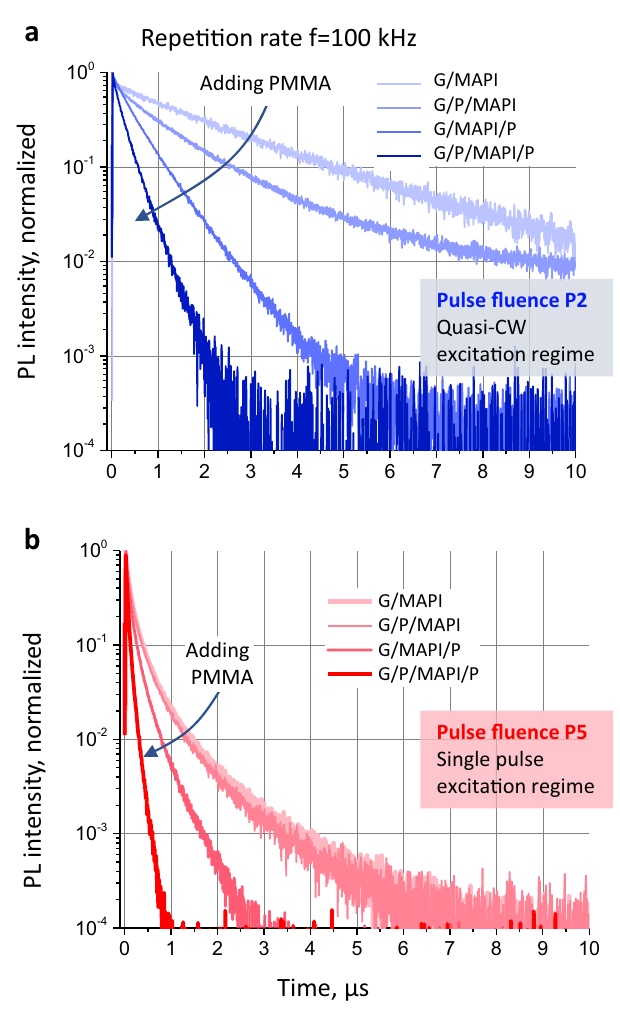
Fig. 3 PL decays of all samples at 100 kHz repetition rate (10 µ s distance between the laser pulses). a Low pulse fl uence (P2). b High pulse fl uence (P5). Note that all decays in a are in the quasi-CW excitation regime, while all decays in b are in the single-pulse excitation regime. Adding PMMA accelerates the PL solely determined by non-linear processes such as Auger